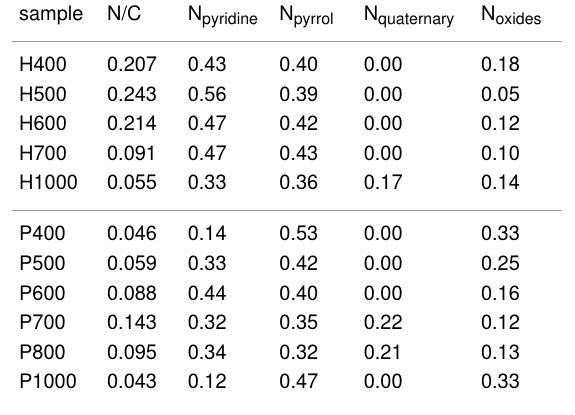
Table 2: Distribution of the N species in H-type and P-type precursors. sample N/C